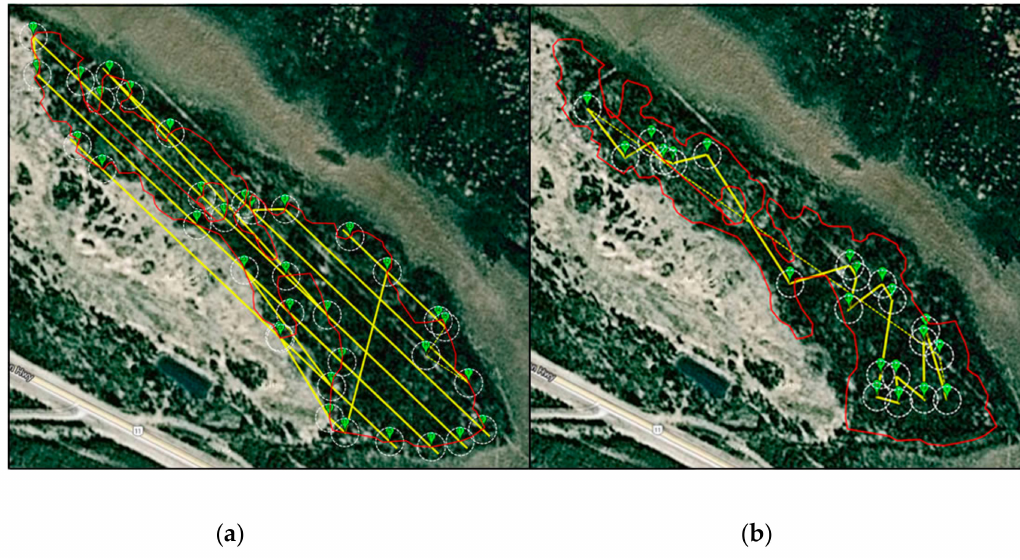
Figure 8. The flight plan for a standard wall-to-wall survey ( a ) is almost six times longer in duration and three times longer in distance than the sample-based approach ( b ) used in this